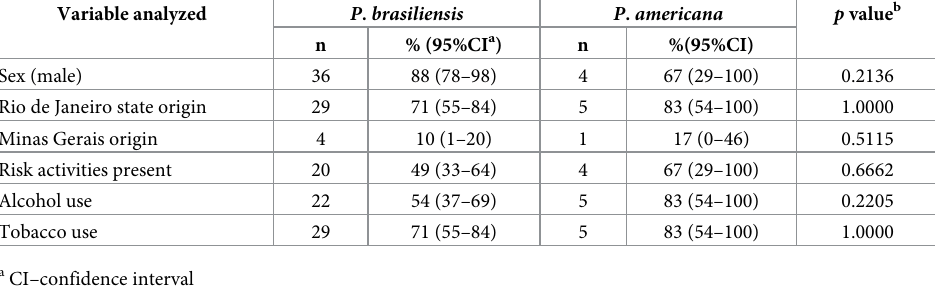
Table 1. Sociodemographic and epidemiological data of patients with paracoccidioidomycosis according to the species identified in this study. Variable